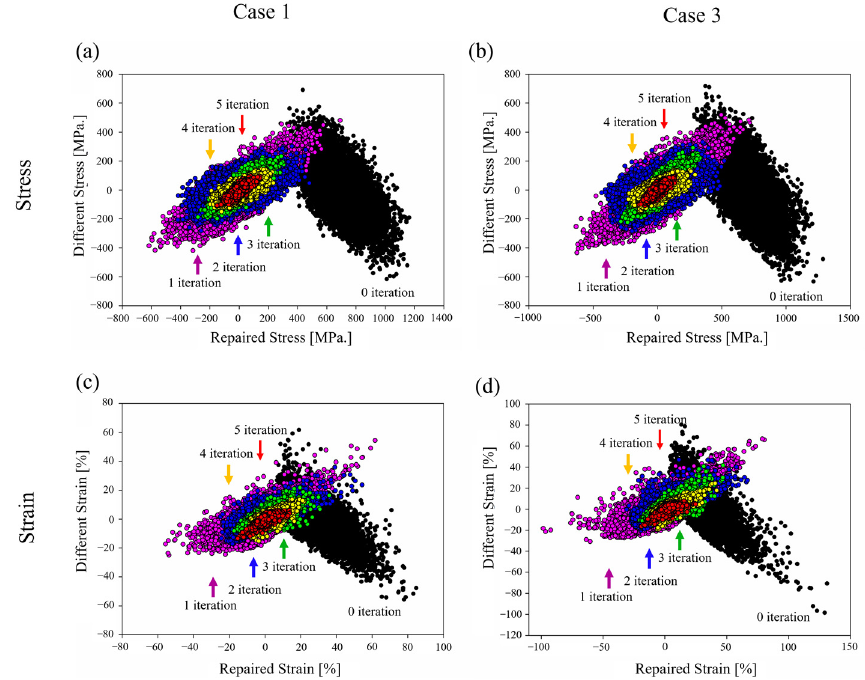
Figure 4. Scatter diagram showing the numerical tendency of stress in ( a ) case 1 ( b ) case 3 and strain in ( c ) case 1 ( d ) case 3 by the proposed iterative method for ferrite phase at 25% global true strain and 0.1 volume fraction.